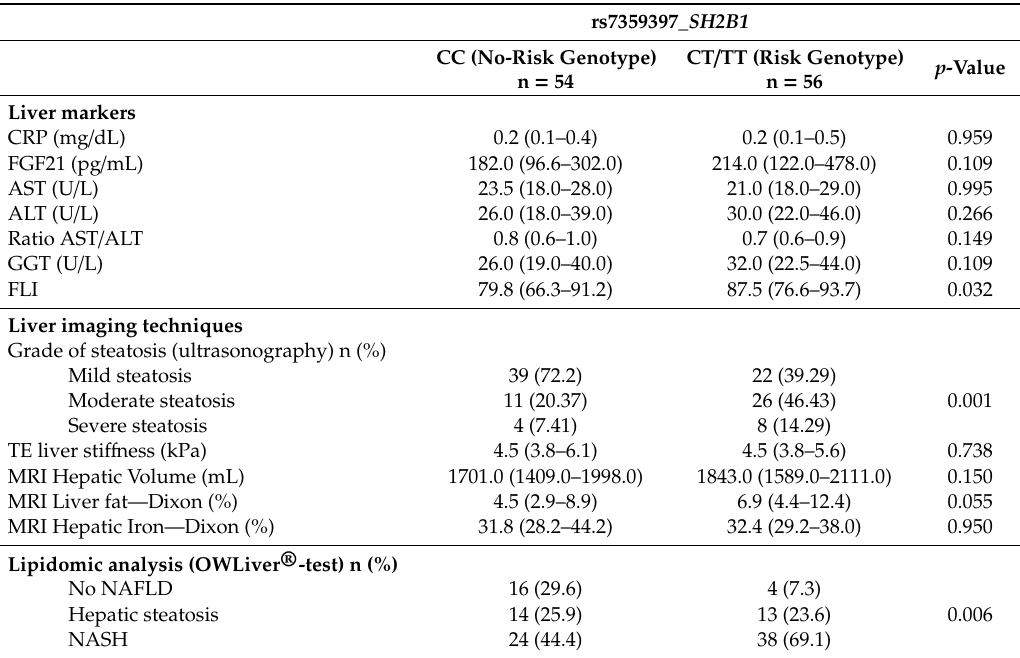
Table 3. Liver status di ff erences depending on the genotype.